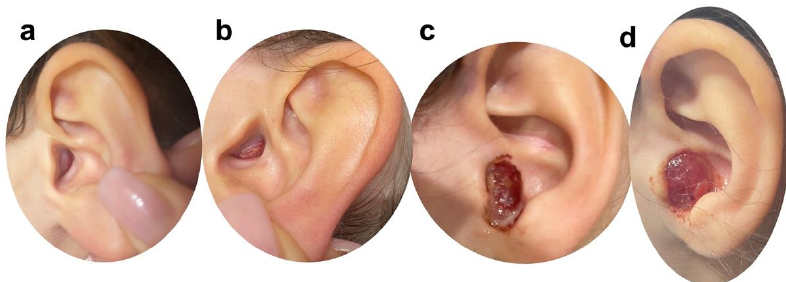
Figure 1. ( a , b ) Left ear. Clinical appearance of the mass at the first follow-up; ( c , d ) Clinical aspect of the mass after 1 week of unsuccessfully anti-biotic treatment. the mass after 1 week of unsuccessfully anti-biotic